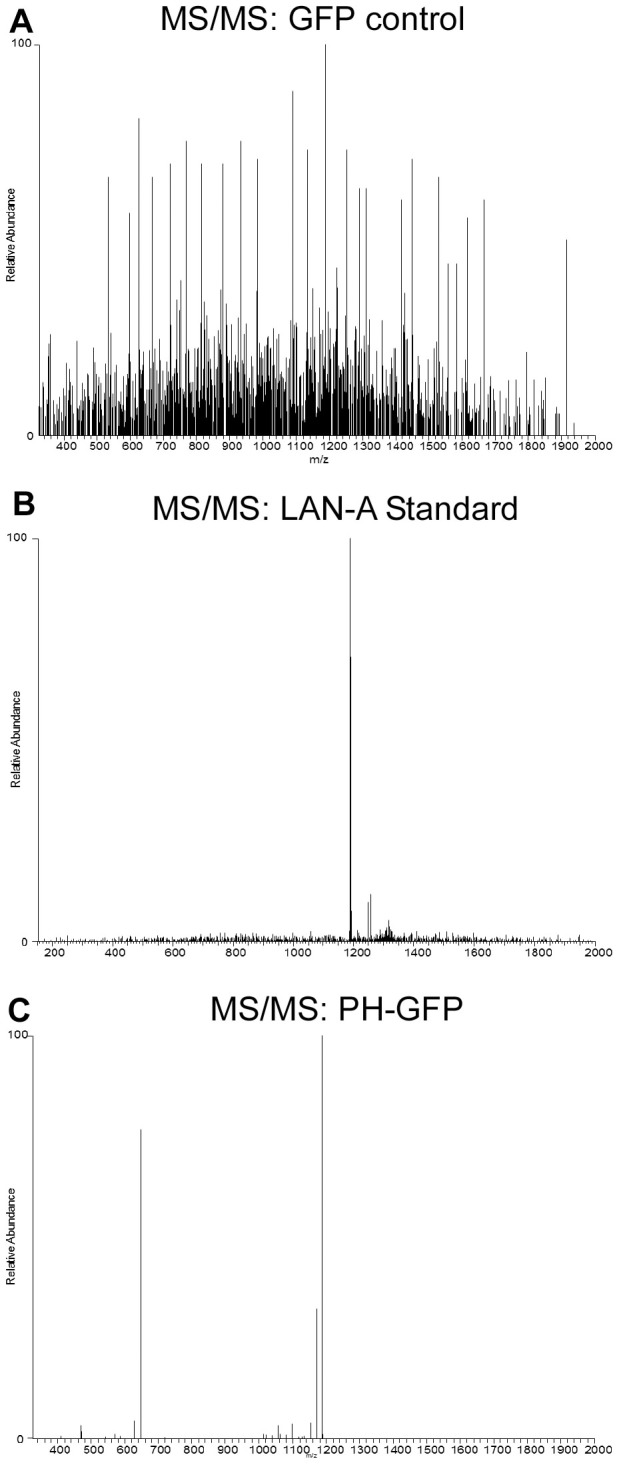
LAN-A interacts with the PH domain of Akt.GFP and PH domain-GFP vectors were transfected into A549-luc-c8 cells and cells were treated with 100 µM LAN-A for 1 h. IP against GFP was done and samples were analyzed by ESI-MS. (A) IP GFP sample showed no prominent peak for LAN-A, (B) whereas IP PH domain-GFP sample had the specific peak for LAN-A. (C) To further confirm this was LAN-A, tandem MS/MS analysis of the IP PH domain-GFP sample showed two fragments for LAN-A (also see
Figure 4E and F
).